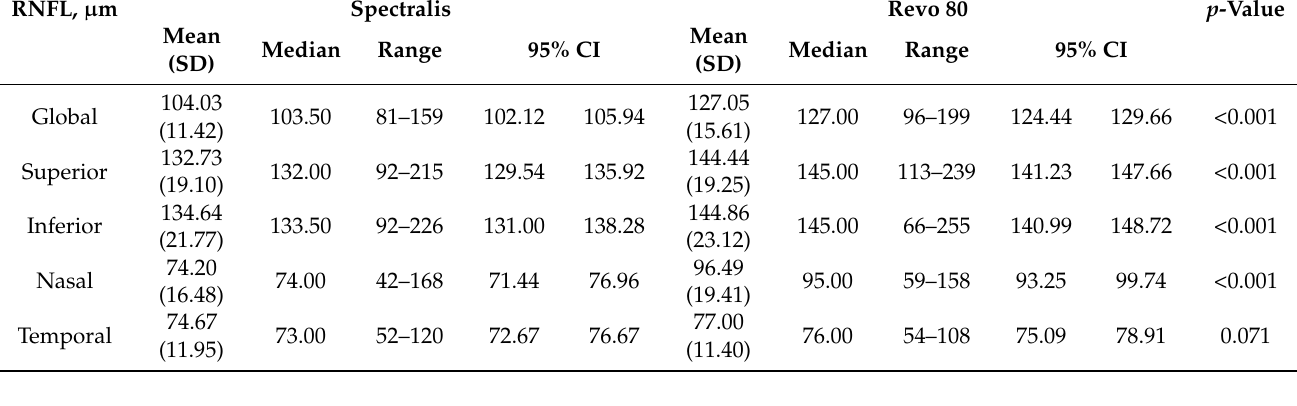
Table 2. Descriptive values of global and sectorial RNFL thickness in the Spectralis and Revo 80.